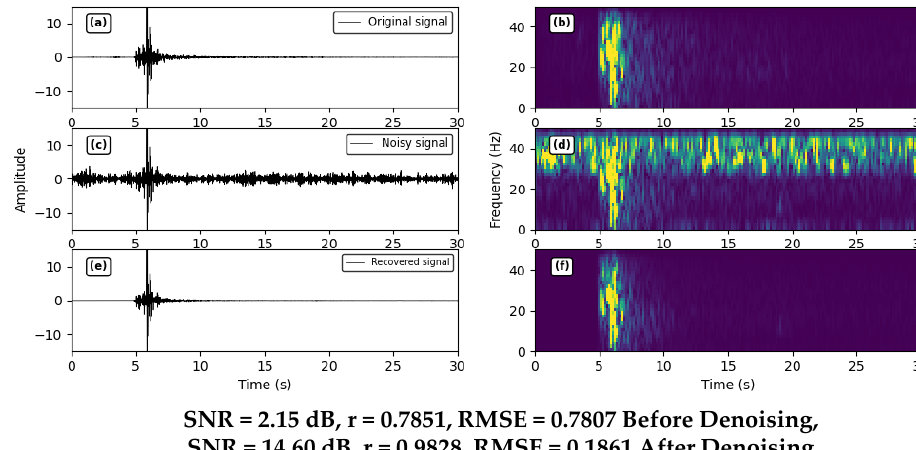
Figure 8. Co-band denoising of medium-high-frequency noise and seismic signals.